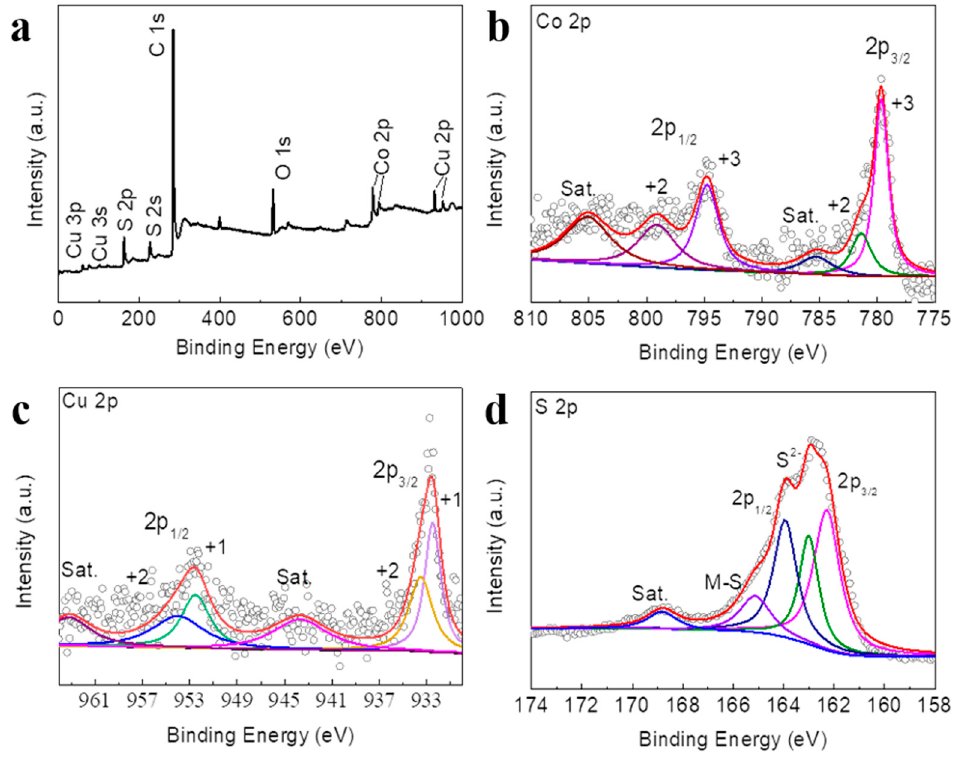
Figure 4. XPS spectra of CuCo 2 S 4 -1/CNT ( a ) Survey; ( b ) Co 2p; ( c ) Cu 2p; and ( d ) S